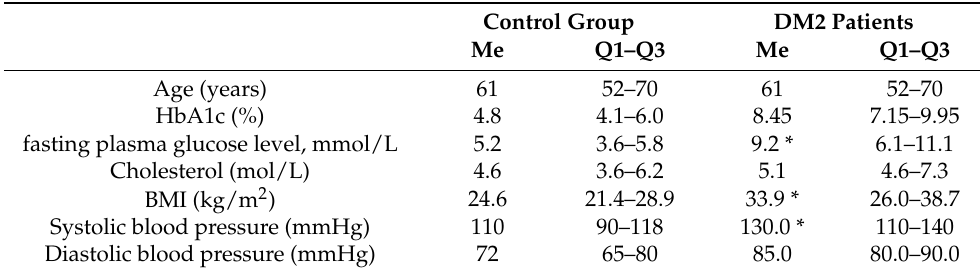
Table 1. Characteristics of the whole study